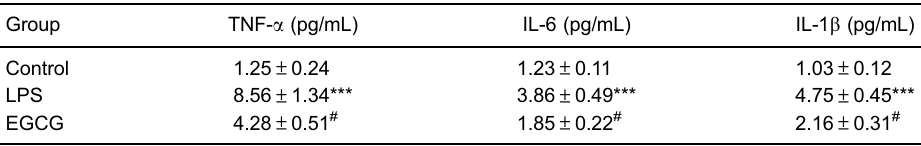
Data are reported as means ± SE. Control group: mice were given saline; LPS group: mice were given lipopolysaccharide (LPS); EGCG group: mice were given epigallocatechin-3-gallate. ***P o 0.001 LPS vs Control; # P o 0.05 EGCG vs LPS